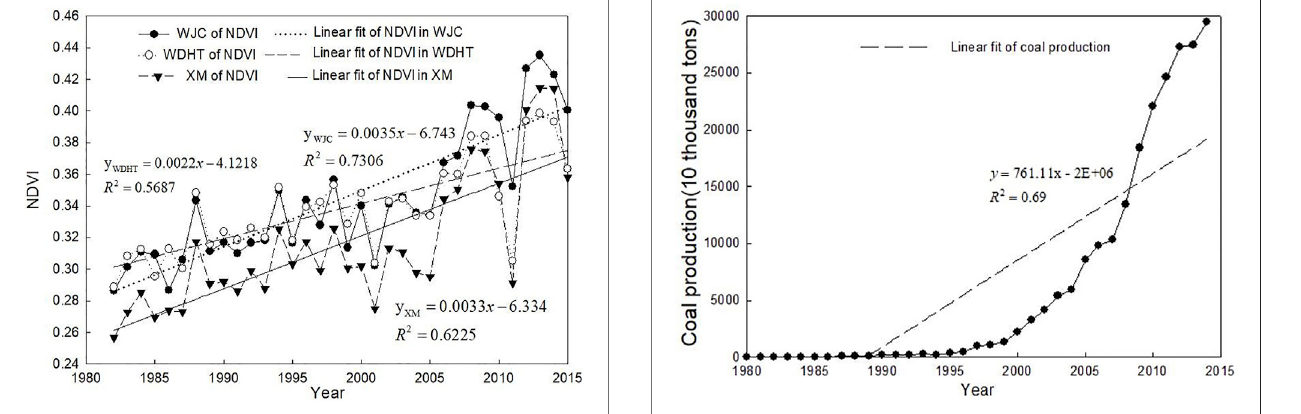
FIGURE 7 | Variation in NDVI in the Kuye River basin during 1982-2015. FIGURE 8 | Coal production in the Kuye River basin during